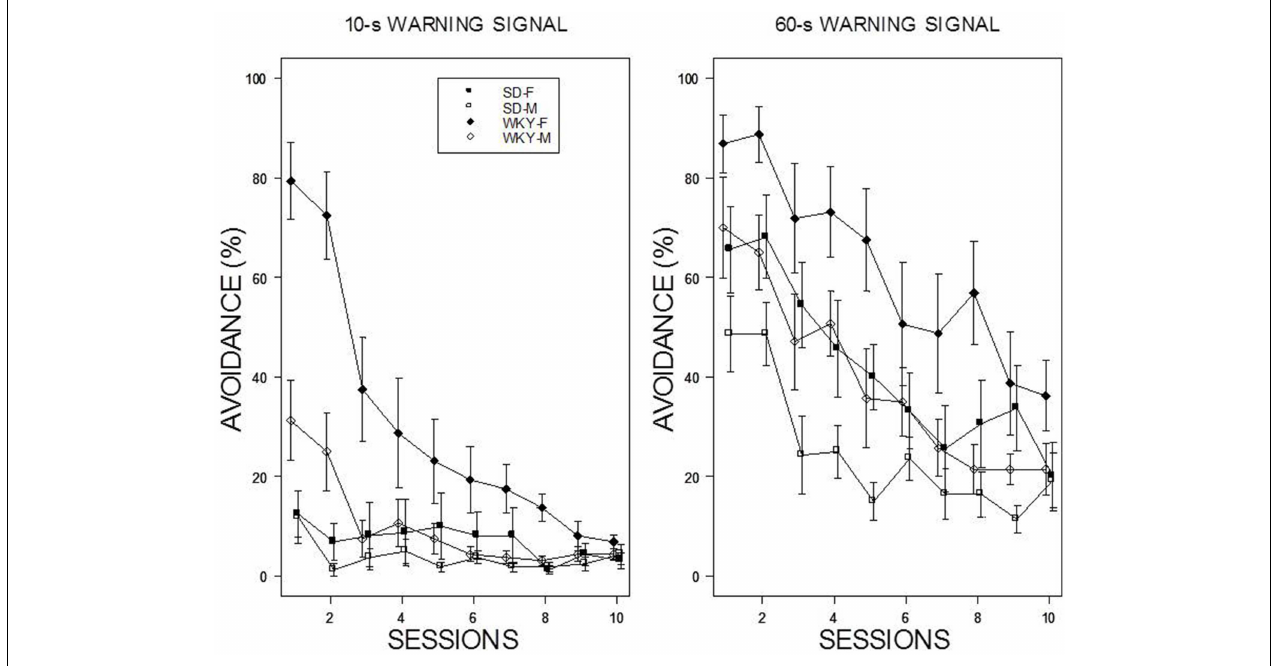
FIGURE 3 | Avoidance extinction. Avoidance performance using a 10-s WS (left panel) and 60-s WS (right panel). The legend is contained within the figure. With respect to the 60-s WS, female rats exhibited slower extinction